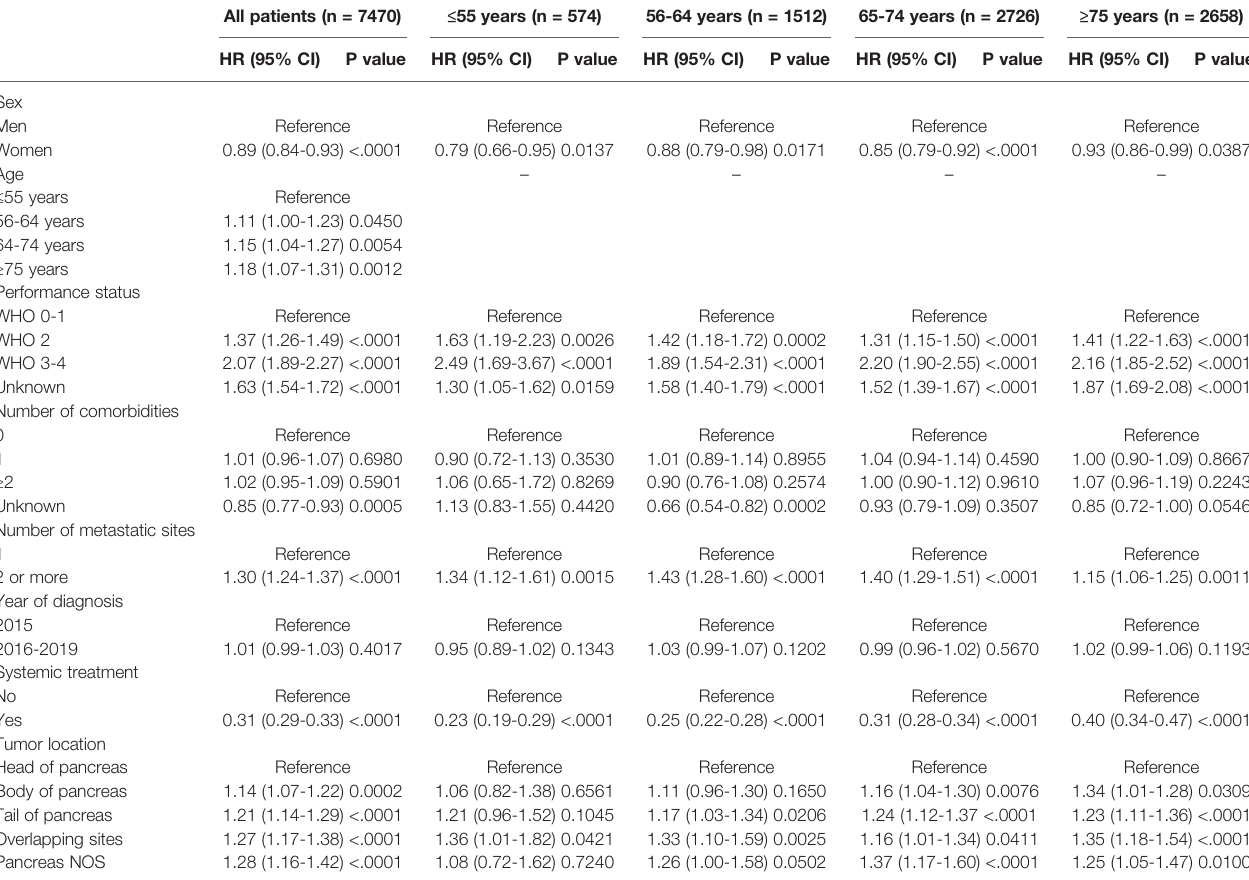
TABLE 4 | Multivariable Cox proportional hazard regression analyses for overall survival. All patients (n =